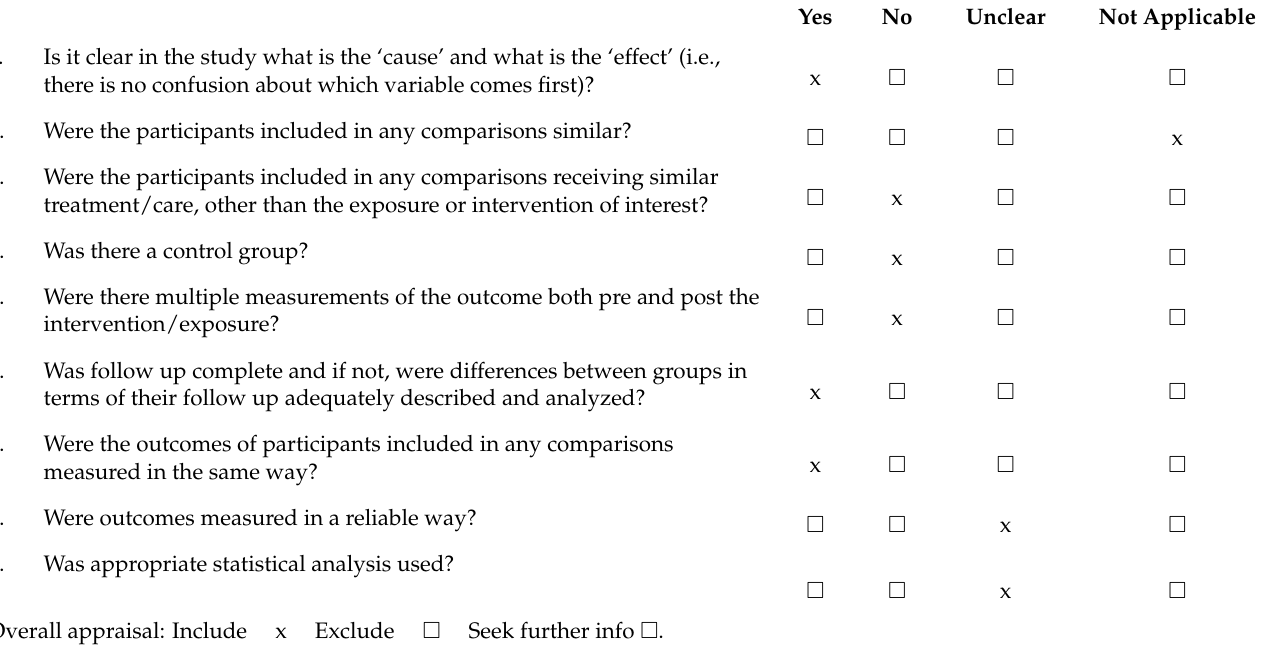
Table A7. JBI Critical Appraisal Checklist for quasi-experimental studies—Huch (1996) study #2. Citation: Huch, R. Physical Activity at Altitude in Pregnancy. Semin. Perinatol. 1996 , 20 , 303–314, doi:10.1016/S0146-0005(96)80023-1. STUDY #2.